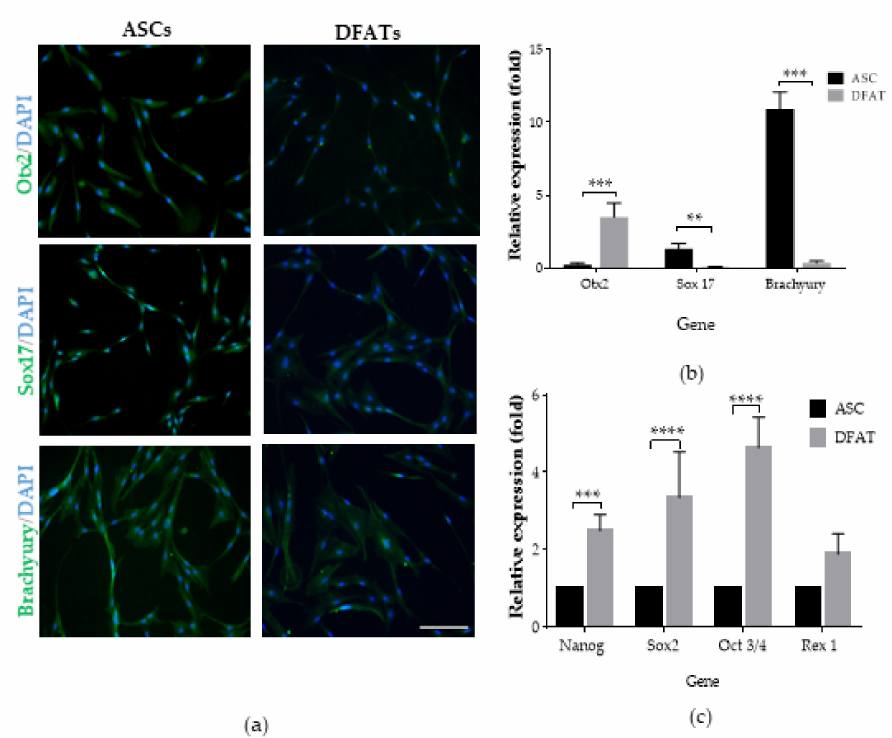
Figure 6. Pluripotent properties of ASCs and DFAT cells: ( a ) Immunocytochemical analysis of differentiation into ectoderm (Otx2), endoderm (Sox17), and mesoderm (Brachyury) at 2nd passage of culture. Scale bar = 100 µ m; ( b ) qRT-PCR analysis of 3-germ-layer gene expression: Otx2, Sox17, and Brachyury in 2nd passage with undifferentiated cells as a control group; ( c ) qRT-PCR analysis of stemness-related transcriptional factors (SRTF) at the 2nd passage of culture with ASCs as a control group. Cells cultured conditions: 5% O 2 , 5% CO 2 , 37 ◦ C. The results are presented as mean values of three experiments ± SEM. The differences were considered statistically significant when p -value <0.05. Statistical significance level * 0.01 < p < 0.05; ** 0.001 < p < 0.01; *** 0.0001 < p < 0.001; **** p <